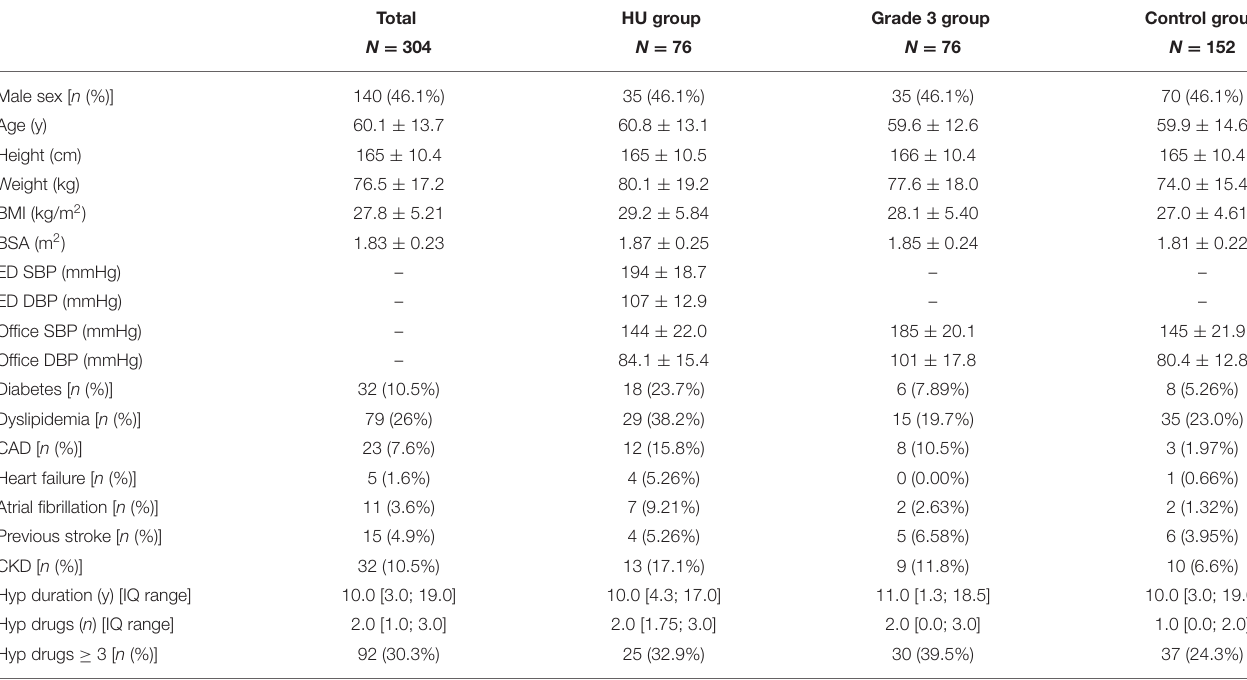
TABLE 1a | Demographic and clinical characteristics of total study population and